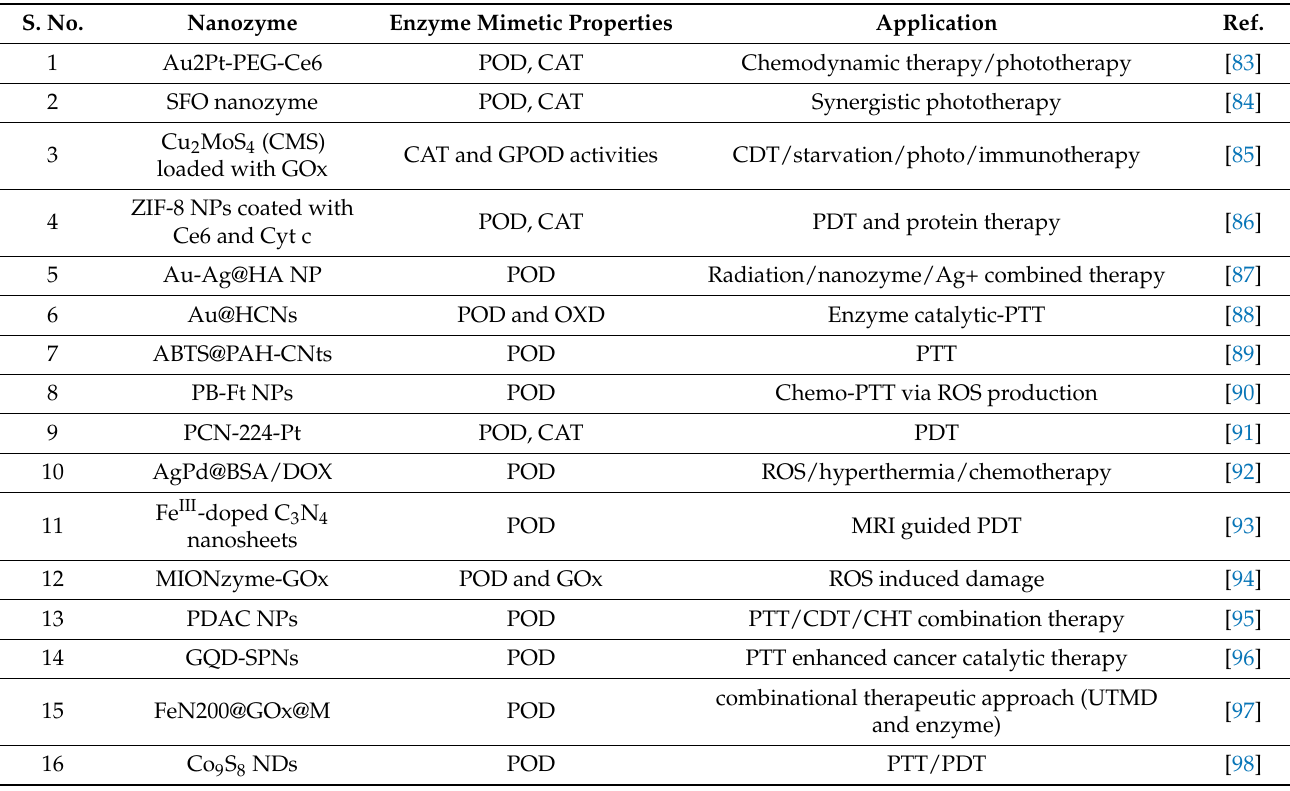
Table 1. Recent reports on POD-based nanozyme-mediated cancer